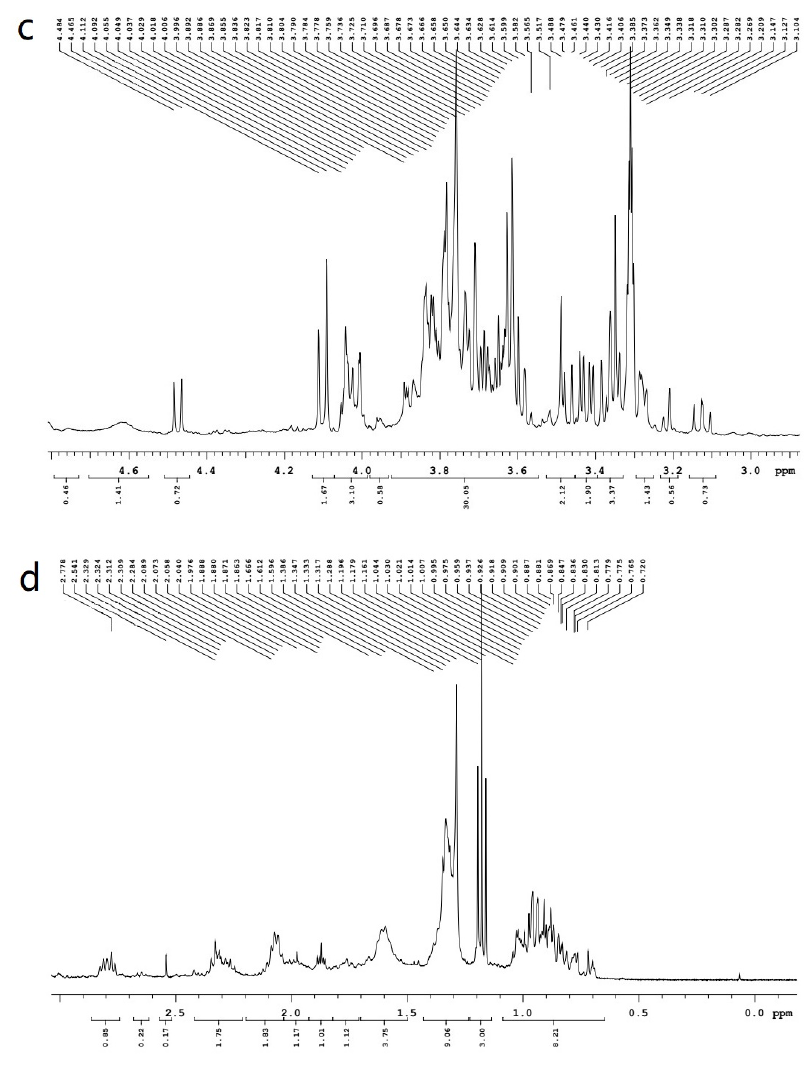
Figure 6. Total distribution of 1 H–NMR of S. holocarpa wood; ( a – d ) are enlarged views.